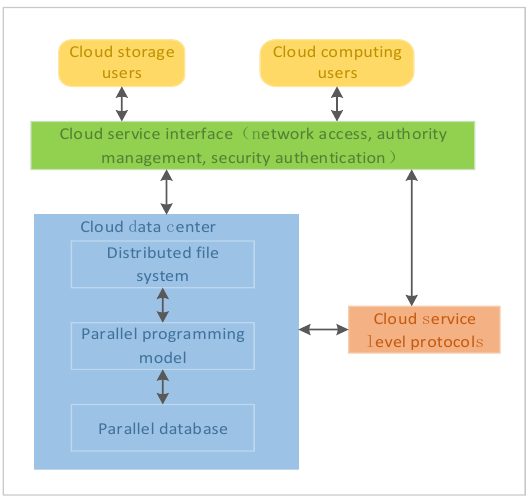
Figure 1. Cloud storage model of blockchain data.